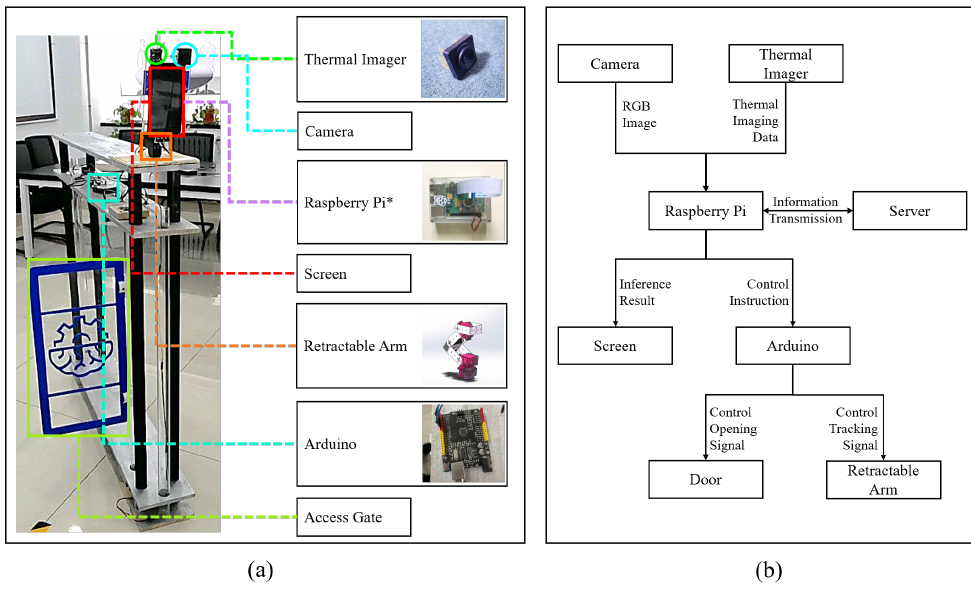
Figure 8. ( a ) The access control gate system prototype for face mask detection consists of seven com- ponents (* the Raspberry Pi is occluded by the screen). ( b ) The overall architecture of the prototype.